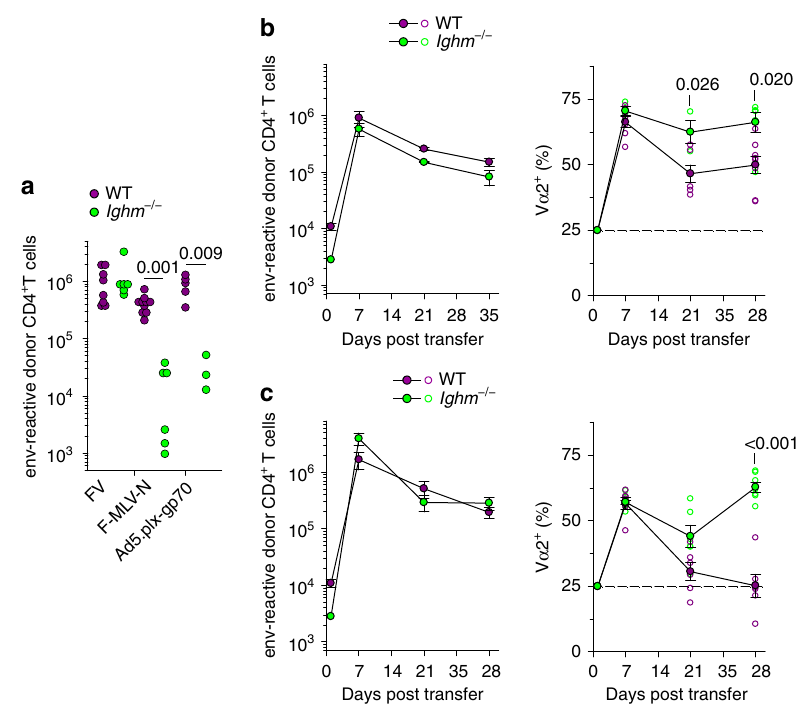
Figure 7 | B-cell-dependent expansion of lower-avidity CD4 þ T-cell clonotypes in diverse infection or immunization settings. ( a ) Absolute number of env-reactive donor EF4.1 CD4 þ T cells 7 days after transfer into WTor Ighm (cid:2) / (cid:2) recipient mice infected either with FV or F-MLV-N or immunized with Ad5.pIX-gp70. Each symbol is an individual mouse. ( b ) Absolute numbers (left) and V a composition (right) of env-reactive donor EF4.1 CD4 þ Tcells in the spleens of WT or Ighm (cid:2) / (cid:2) recipient mice after adoptive T-cell transfer and FBL-3 tumor challenge ( n ¼ 3–8 mice per time point). ( c ) Absolute numbers (left) and V a composition (right) of env-reactive donor EF4.1 CD4 þ Tcells in the spleens of WTor Ighm (cid:2) / (cid:2) recipient mice after adoptive T-cell transfer and env 122–141 peptide immunization ( n ¼ 6–9 mice per time point).